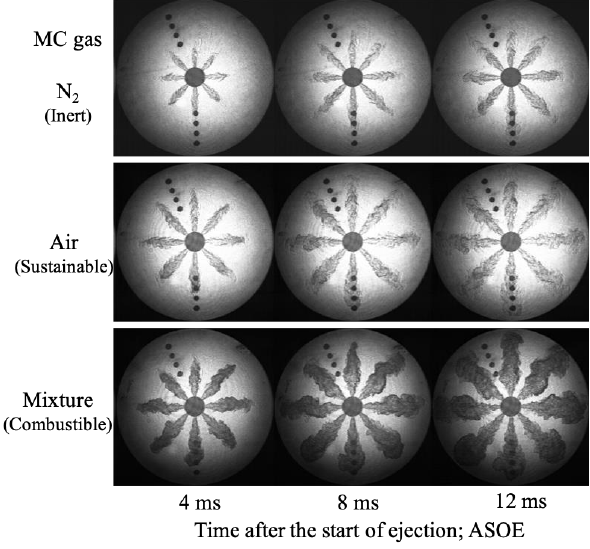
Fig. 8. Shadowgraphs of torch flames under different main chamber gas conditions; “combustible” (lean CH 4 /air mixture), “sustainable” (artificial air), and “inert” (N 2